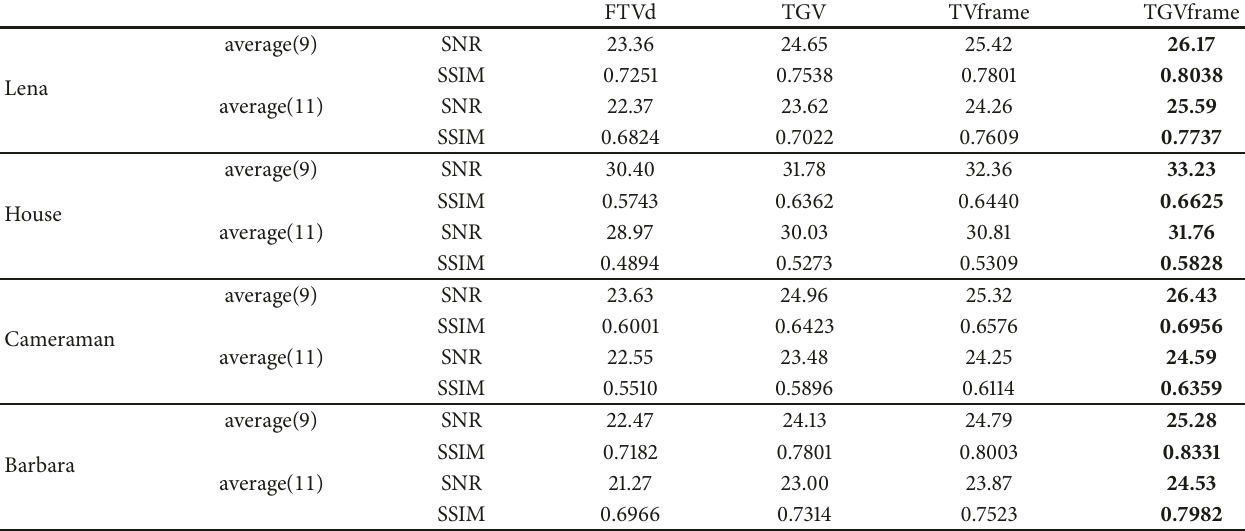
Table 2: Restoration results of different methods under average blur with noise level 𝜎 = 0.1 .